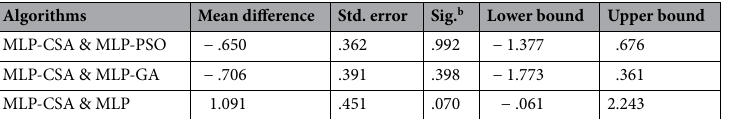
Table 6. Pairwise comparisons of all algorithms prediction error for the self-cleaning efficiency. *The mean difference is significant at the .05 level. b Adjustment for multiple comparisons: Bonferroni.